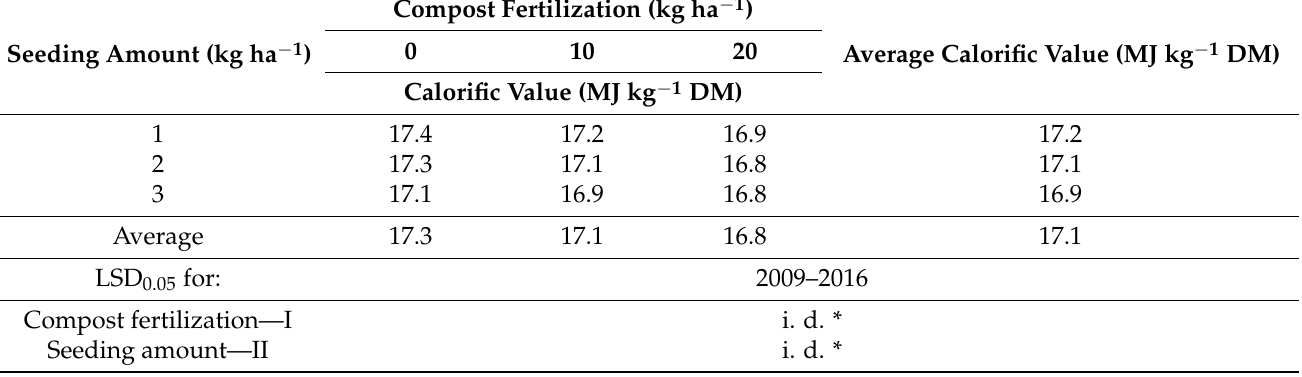
Table 9. Effects of seeding amount and fertilization with compost on the average calorific value (MJ kg − 1 DM) of Sida during the years of full use